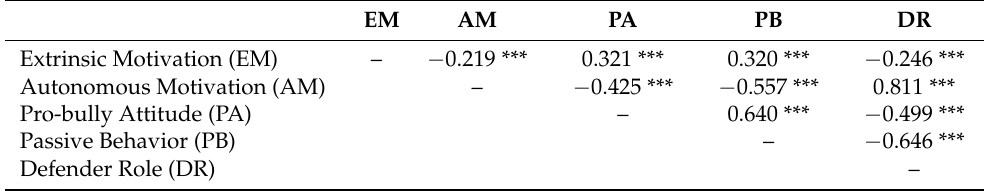
Table 1. CFA covariance matrix.